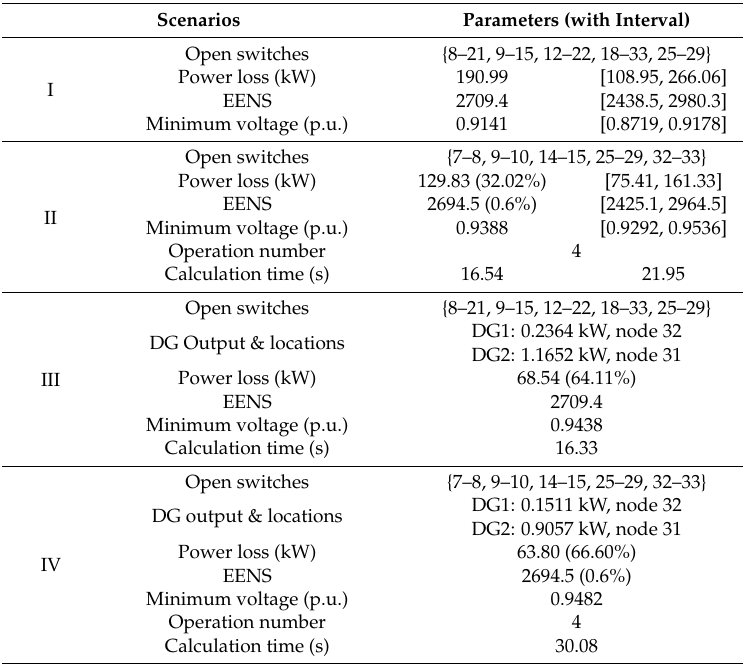
Table 2. The optimization result of IEEE 33-bus